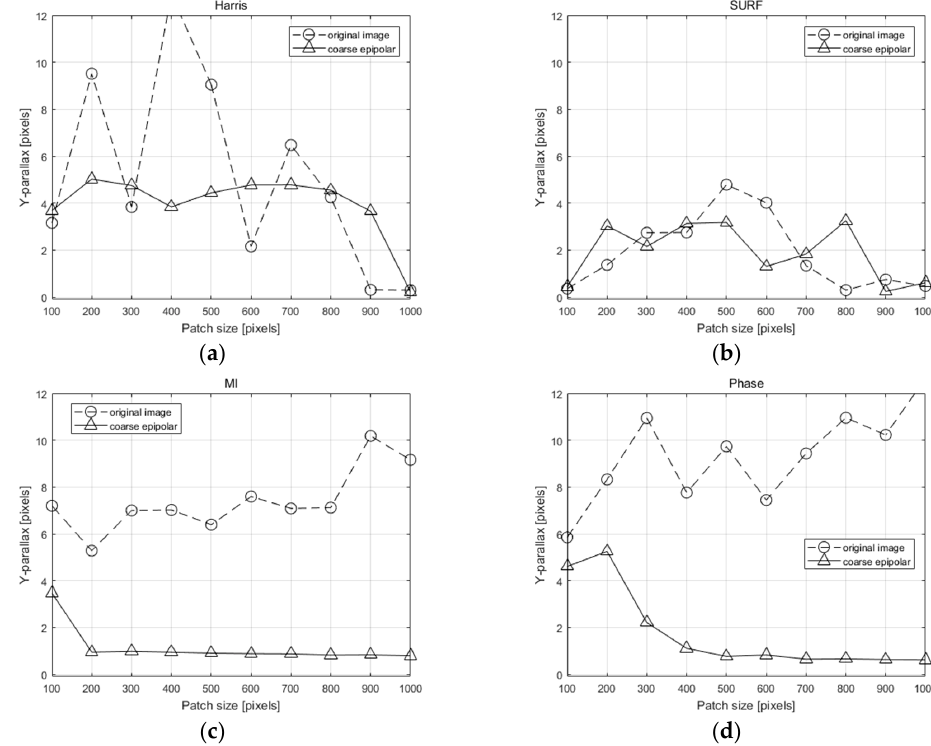
Figure 23. Y-parallax (across-track Kompsat-3A): ( a ) HARRIS–FREAK ( b ) SURF, ( c ) MI, and ( d ) PC.